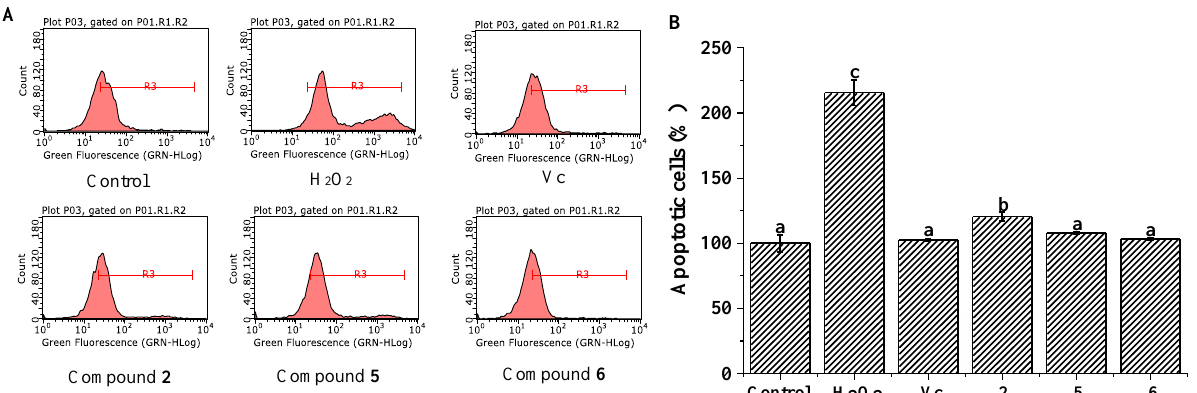
Figure 3. The inhibitory effects of compounds 2 , 5 , and 6 on intracellular ROS in H 2 O 2 -induced HepG2 cells. ( A ) Flow cytometry analysis; ( B ) the ROS intensity of different groups. All the values are presented as mean ± SD ( n = 3). Means (bar values) with different letters indicate significant differences ( p < 0.05).